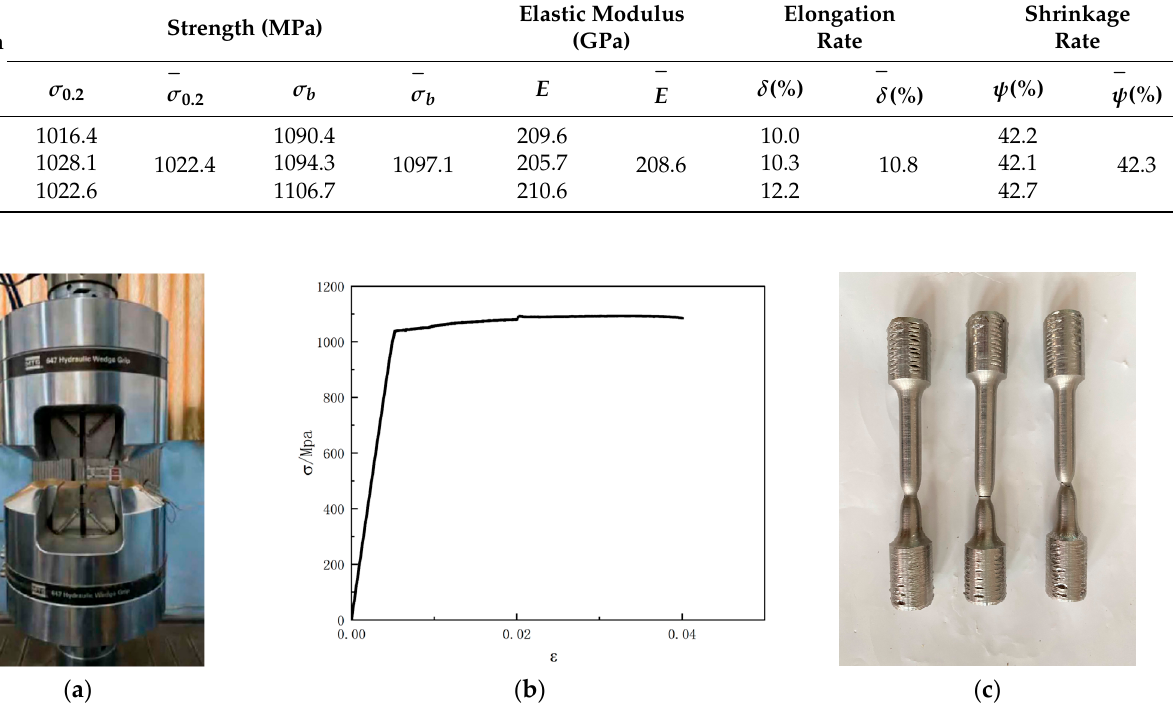
Figure 4. Static tensile tests. ( a ) Test setup. ( b ) Full stress ‐ strain curve. ( c ) Failure mode.